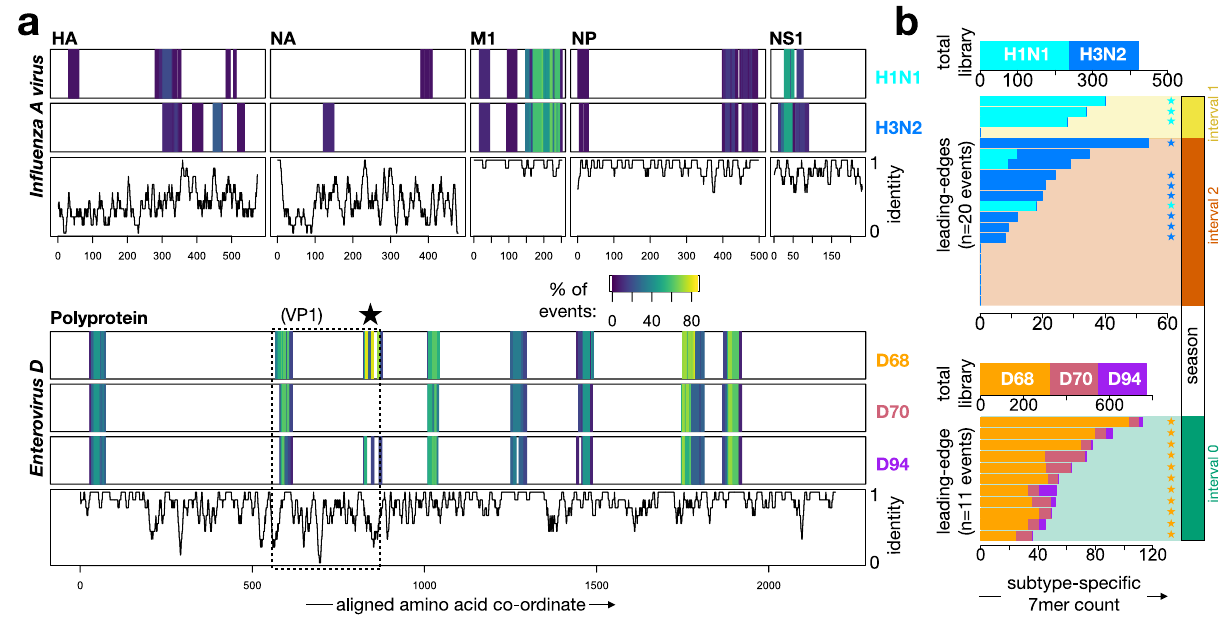
Fig. 4 | Epitope-level analysis resolves In fl uenza A virus and Enterovirus D epi- demic waves to the sub-species level. a Leading-edge peptides from the events detected in Fig. 2 for In fl uenza A virus ( upper ) and Enterovirus D ( lower ) were mapped onto representative viral proteomes of the dominant respective circulat- ingsubtypes( In fl uenzaAvirus — H1N1,H3N2; EnterovirusD — D68,D70,D94).Shown in the upper rows of each panel are multiple sequence alignments for the reactive proteinsofeachvirus,coloredateachpositionbythefractionoftotaleventswhose leading-edge peptides contain the 7mer at that position for each subtype. The lower row of each panel shows average amino acid identity between the subtype representatives across a sliding window of 9 amino acids centered at each amino acidpositioninthealignment.Thedottedboxinthe EnterovirusD panelshowsthe position of the surface protein VP1, and the star indicates a frequently-recognized